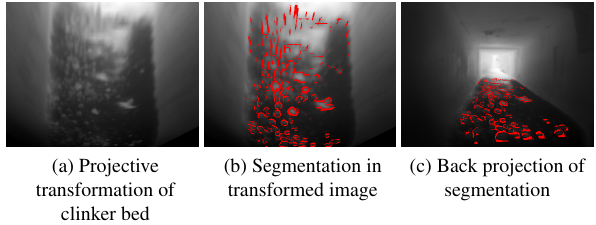
Figure 4. Projective transformation and exemplary application.